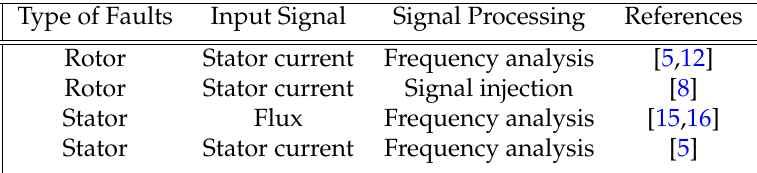
Table 4. Diagnostic techniques in term of adopted signal processing techniques and input signal